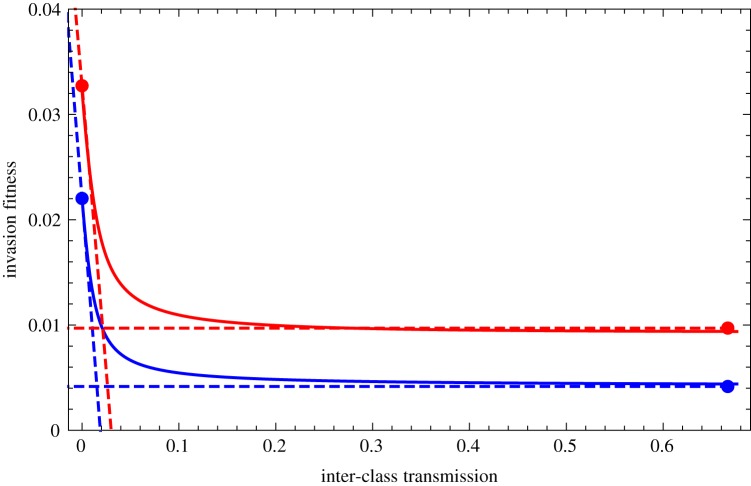
The invasion fitness λS (blue) and λR (red) are shown as a function of inter-class transmission. The plain line is the simulation, the bullets are the ‘no inter-class transmission’ and ‘full inter-class transmission’ approximations (equations (3.1) and (3.3)), the horizontal dashed lines shows again the full inter-class transmission approximation (equation (3.3)) and the declining dashed lines the Taylor series analysis around 0 inter-class transmission (equation (3.2)). We model three classes of equal sizes N1 = N2 = N3 = 1/3. The baseline parameters are clearance rates uS = uR = 1.1 month−1; treatment cessation ω = 4 month−1; baseline transmission rate β = 10 month−1, cost of resistance c = 0.04; treatment varies across three classes, with rates τ1 = 0.02, τ2 = 0.035, τ3 = 0.05 month−1 and treatment is 10% higher in the colonized individuals, , ,  month−1; antibiotic clearance rate for the resistant, aR = 0 and for the sensitive aS = 30 month−1.